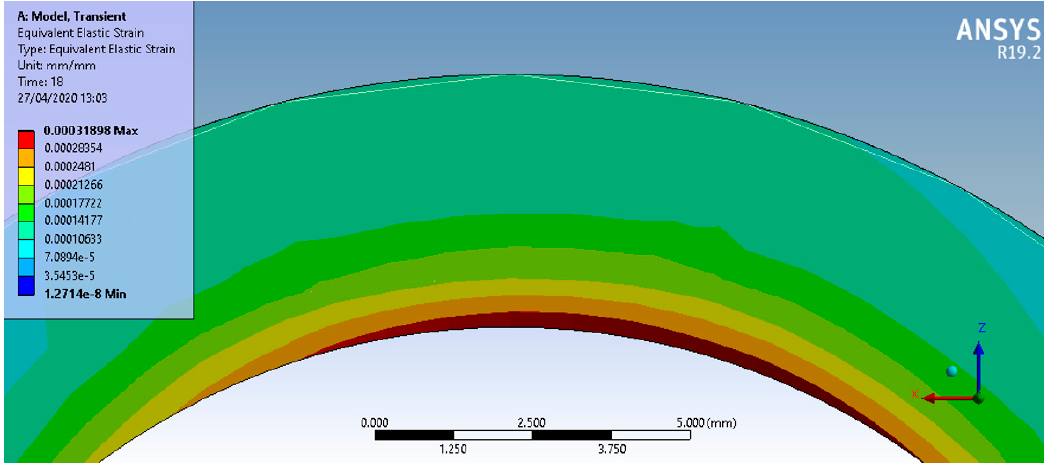
Figure 8. Equivalent stresses (von Mises) developed in the test piece.